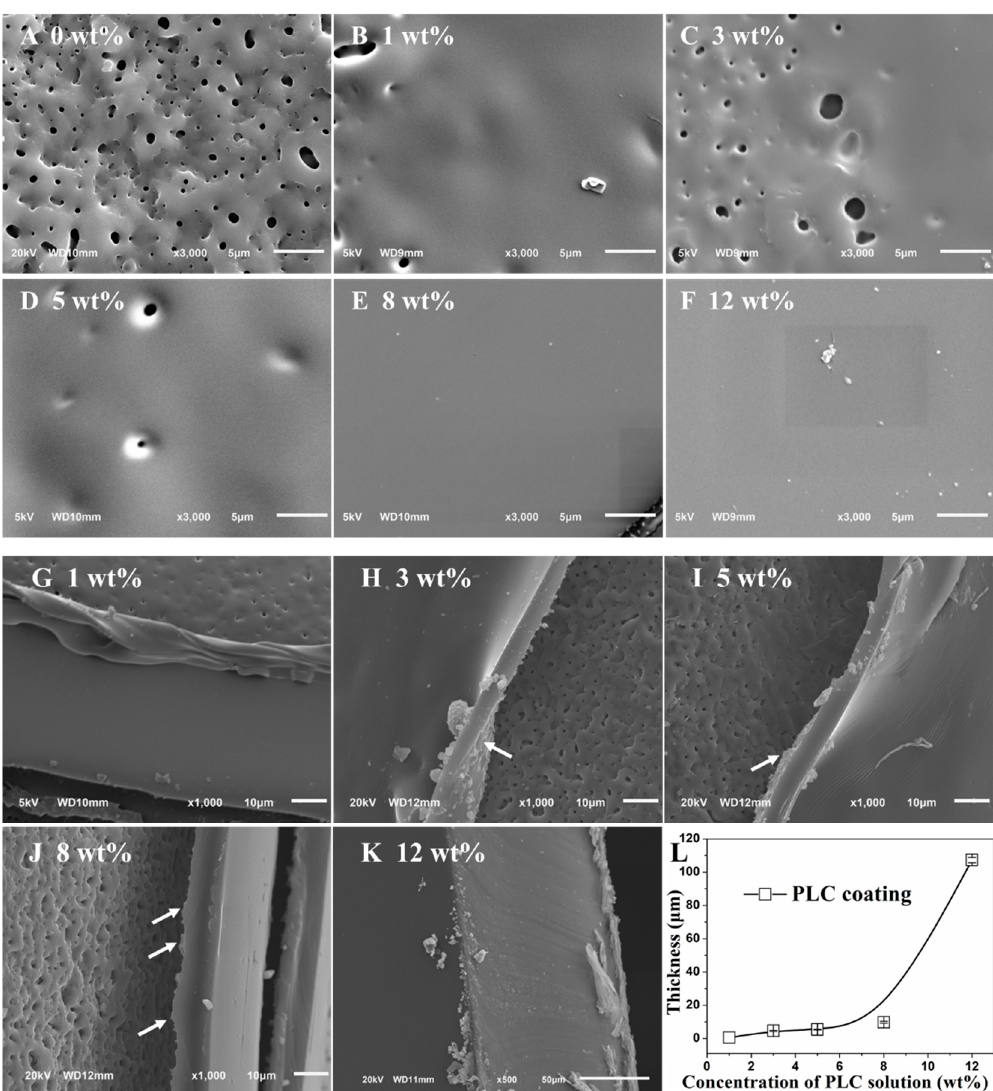
Figure 4. ( A ) Surface morphology of MAO coating; ( B – F ) Surface morphology and ( G – L ) cross-section morphology and thickness of PLC resorbable coating at solution concentrations of 1, 3, 5, 8, and 12 wt %.